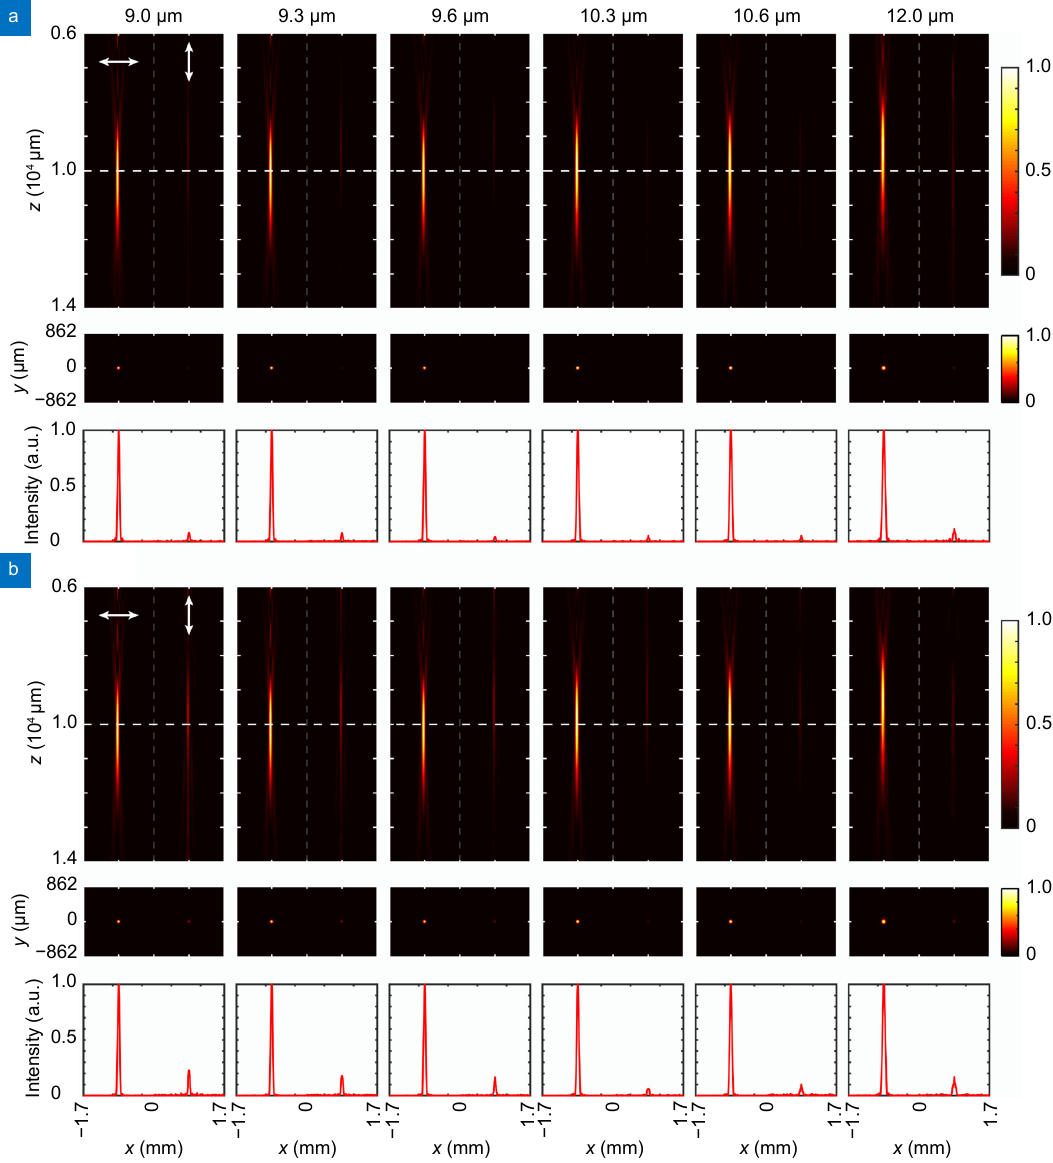
Fig. 3 | Simulation results of X- and Y-polarization-sensitive metalenses designed with ( a ) polarization-dependent optimization method versus ( b ) conventional design method for X-polarized incident light. The upper diagram shows the intensity distribution in the x - z plane, and the white dashed line is the position of the focal plane. The middle figure is the focal plane intensity profile. The lower part is the normalized intensity pro- file along the white